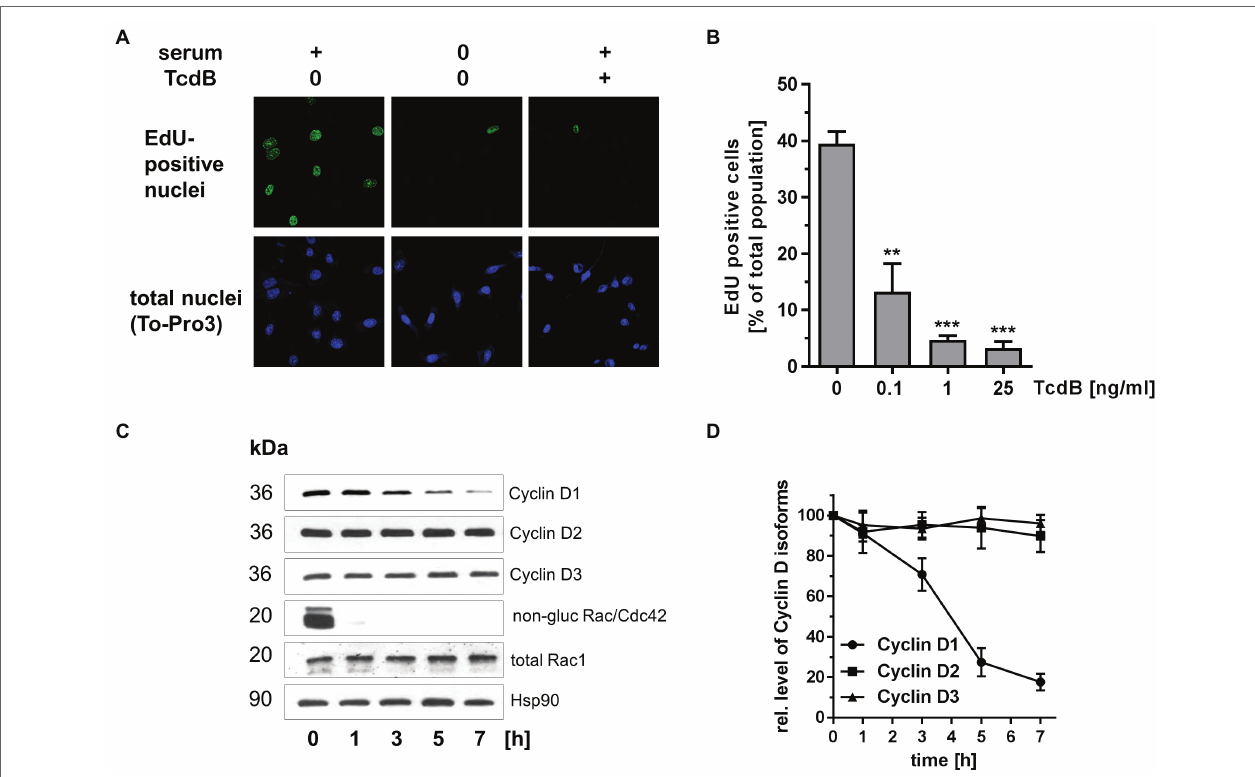
FIGURE 2 | Effects of TcdB in human colonic epithelial cells (HCEC). (A) HCEC were treated with TcdB (25 ng/ml) or maintained in serum-starved medium as positive control for 24 h. Actively replicating S-phase cells were labeled with EdU and visualized by confocal microscopy. Upon fixation of cells, nuclei were counterstained with TO-PRO-3. (B) HCEC were treated with the indicated concentrations of TcdB for 24 h. Actively replicating S-phase cells were labeled with EdU and visualized by confocal microscopy. The number of EdU-positive per TO-PRO-3-positive nuclei was determined. Signals from EdU-positive cells were quantitatively evaluated using ImageJ software ( n = 3). *** p < 0.001, ** p < 0.01. (C) HCEC were treated with TcdB (25 ng/ml) for the indicated time. The relative cellular concentrations of the indicated proteins were determined using Western blot analysis. Representative Western blots are presented. (D) Signal intensities obtained from the Western blots ( n = 3) were quantified and normalized to the signal of Hsp90. The concentration of the indicated proteins in non-treated cells was set 100. Values are given as mean ± SD of three independent